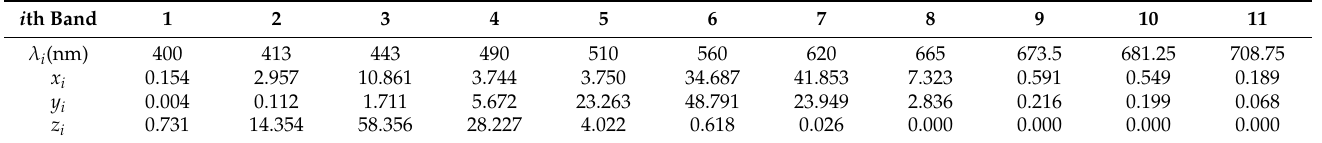
Table A1. Linear coefficients to calculate the chromaticity values based on OLCI bands [36].